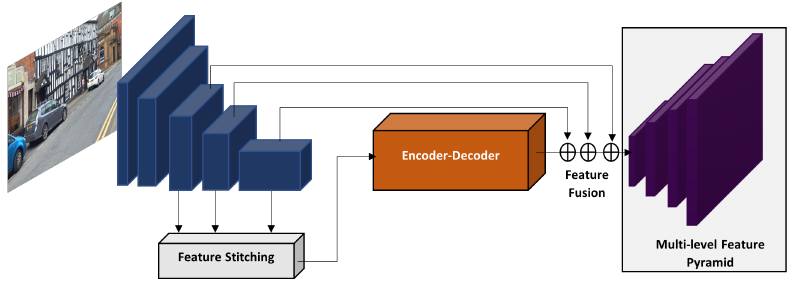
Figure 16. Multi-level FPN YOLO : three convolutions layers at different levels are stitched, then this stitched features are encoded and decoded. Finally, the original convolutional layers that were used by the stitching component and the decoded stitched features are fused to yield a multilevel feature pyramid